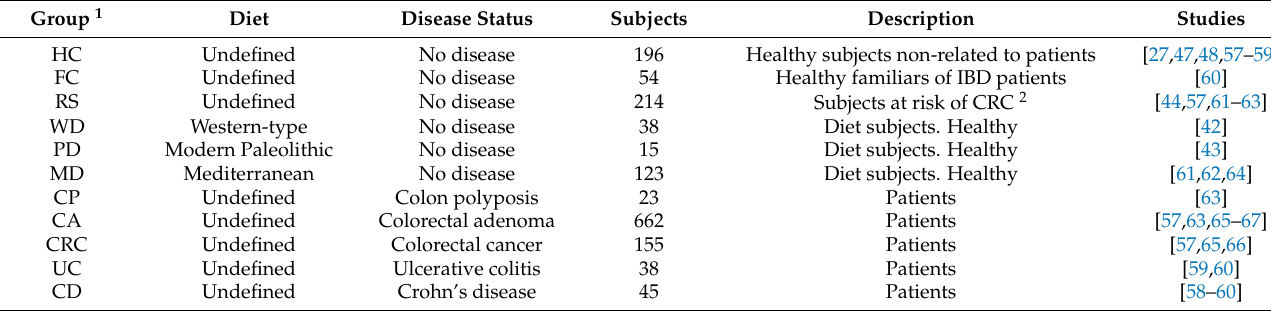
1 Groups: Healthy subjects (HC) and healthy familiars of IBD patients (FC). Subjects at risk of developing colorectal cancer (RS), patients with colon polyps (CP), colon adenoma (CA), colorectal cancer (CRC), Crohn’s disease (CD), and ulcerative colitis patients (UC). Subjects following a Mediterranean (MD), modern Paleolithic (PD) or Western-like diet (WD). 2 Further criteria information in Table